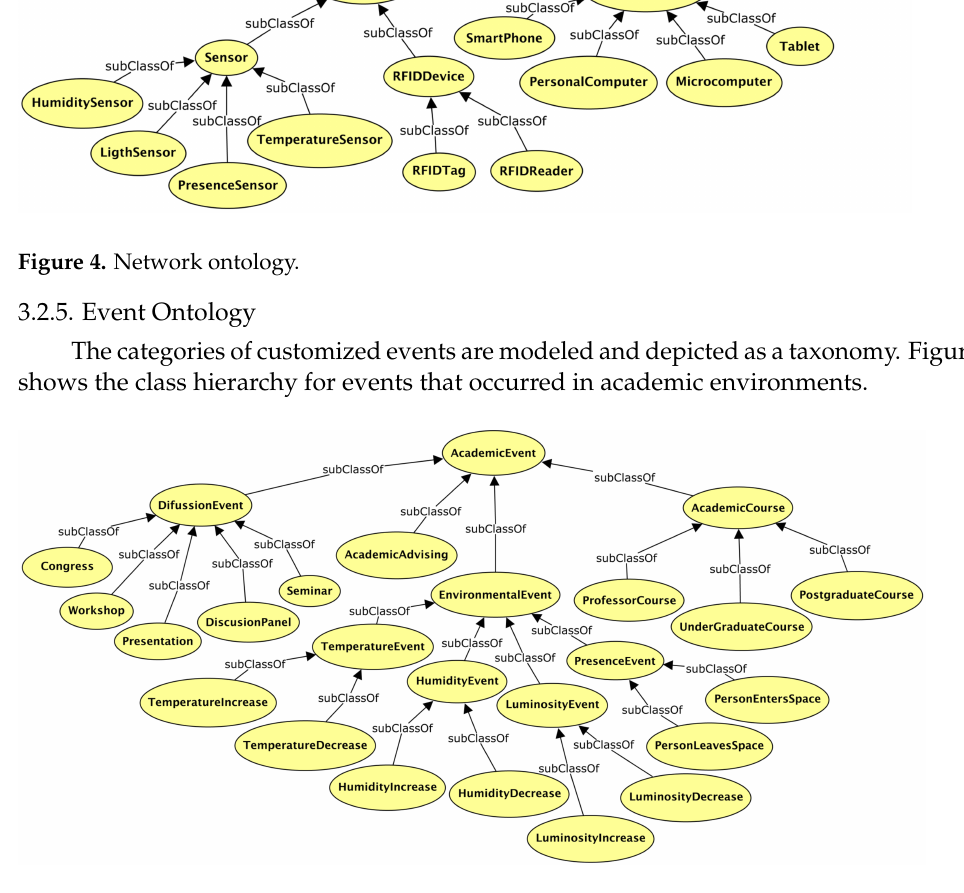
Figure 5. Class hierarchy for event